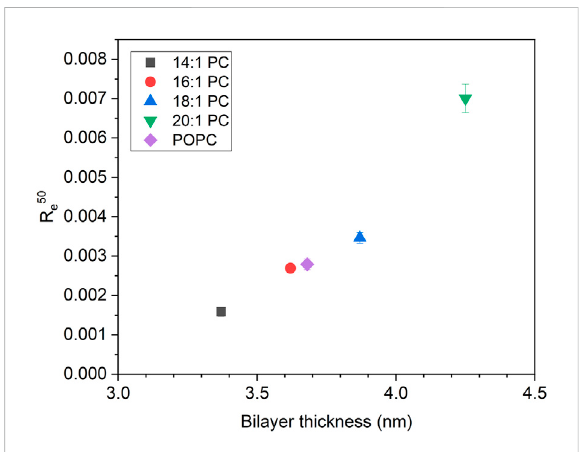
FIGURE 6 The mole ratio of membrane-bound tolaasin per lipid to cause 50% leakage (R e 50 ) as a function of hydrophobic bilayer thickness for lipid membranes composed of the tested lipids according to Kucerka et. al. (2008), Kucerka et. al. (2009) (see color/symbol code in the fi gure). R e 50 errors are standard errors of linear regression of equi-activity curves at 30 μ M and 300 µM lipid, which were previously shown in Figure 3. At 300 µM lipid, membrane permeabilizing activity